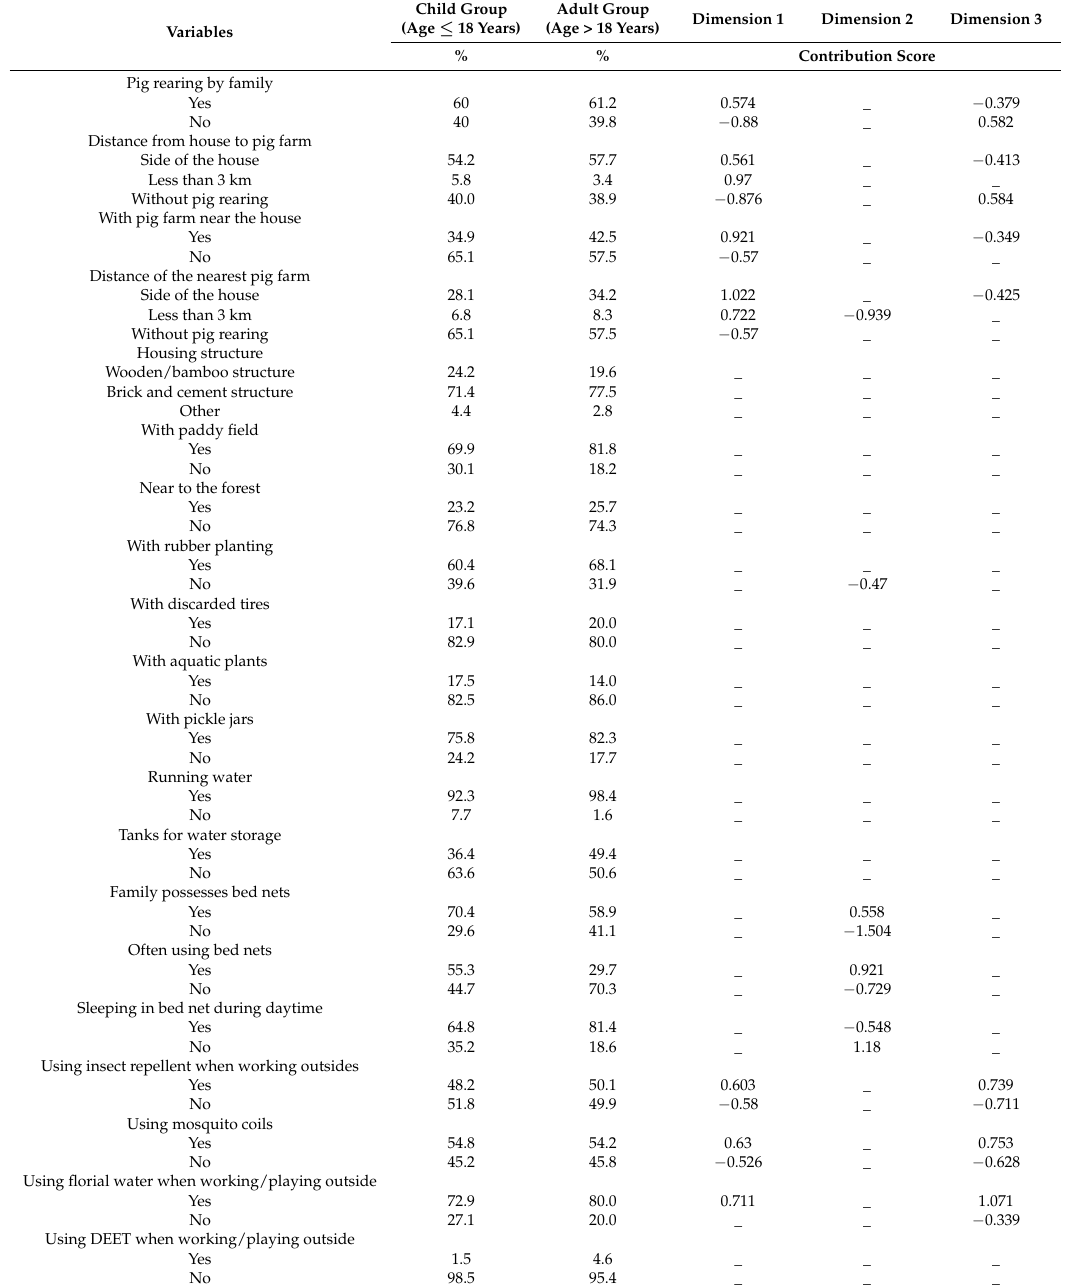
Table 2. Comparison of environmental factors and personal behaviors between the child group and adult